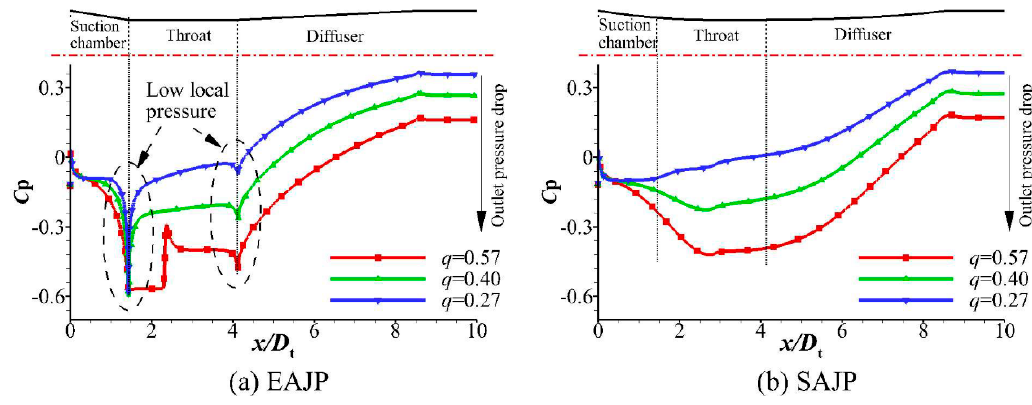
7 of 15 Figure 6. Performance curves. Table 2. Comparison of performance. η max